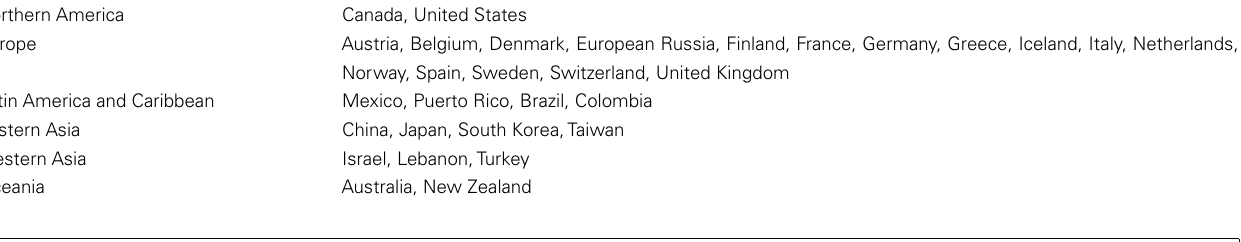
Table 2 | Study country of origin by world region (UN, 2011).